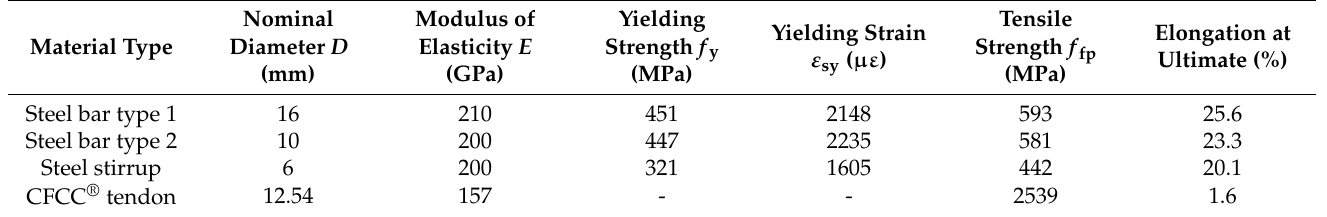
Table 2. Material properties of reinforcements.